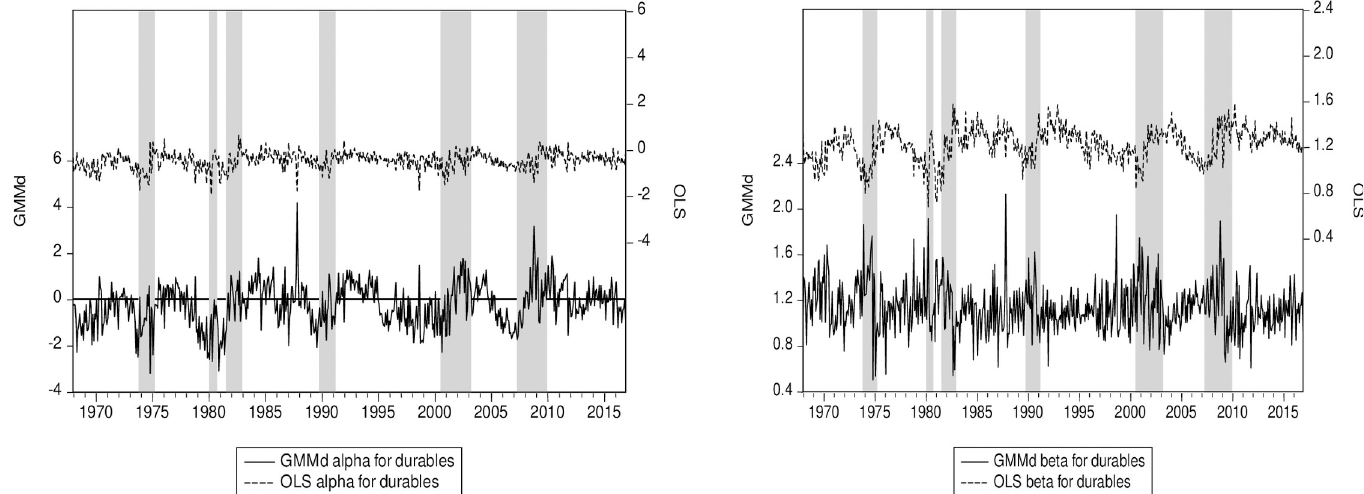
Fig 6. (a) Durables alpha for RIV GMM and OLS. (b) Durables beta for RIV GMM and OLS. Notes: This sector has the highest OLS beta among the 12 sectors. RIV GMM (GMMd) is our robust instrumental variables approach. Shaded areas represent US recessions or crises. The OLS and GMM series are plotted on the same